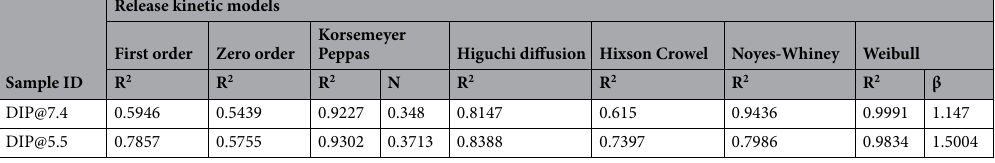
Table 6. Drug release kinetics of Dox-loaded ICG